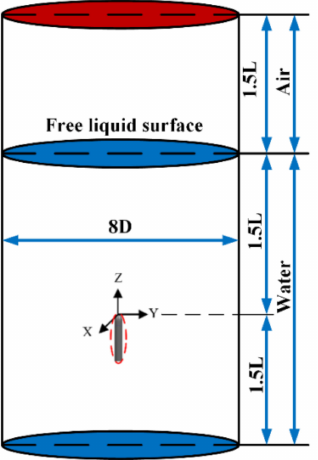
Figure 7. Computational domain.